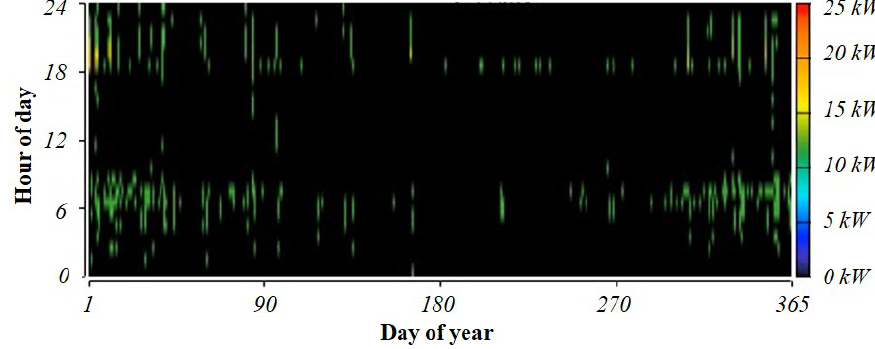
Figure 16. Yearly power output from diesel generator for PV-Wind-BSS-DG